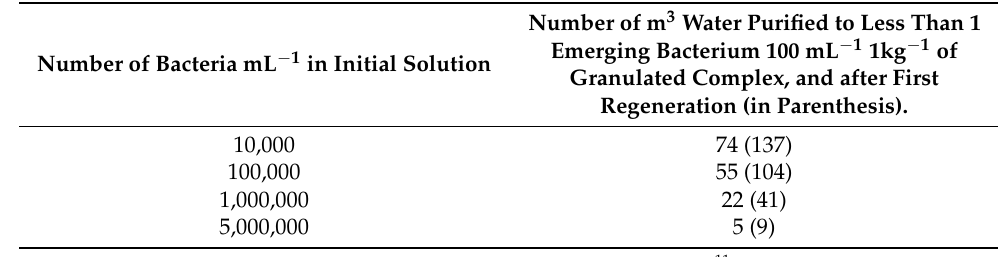
Table 7. Capacities of filters (1m long) filled with granulated BDMHDA-clay for removal of E. coli bacteria at a flow velocity of 10 m/h.